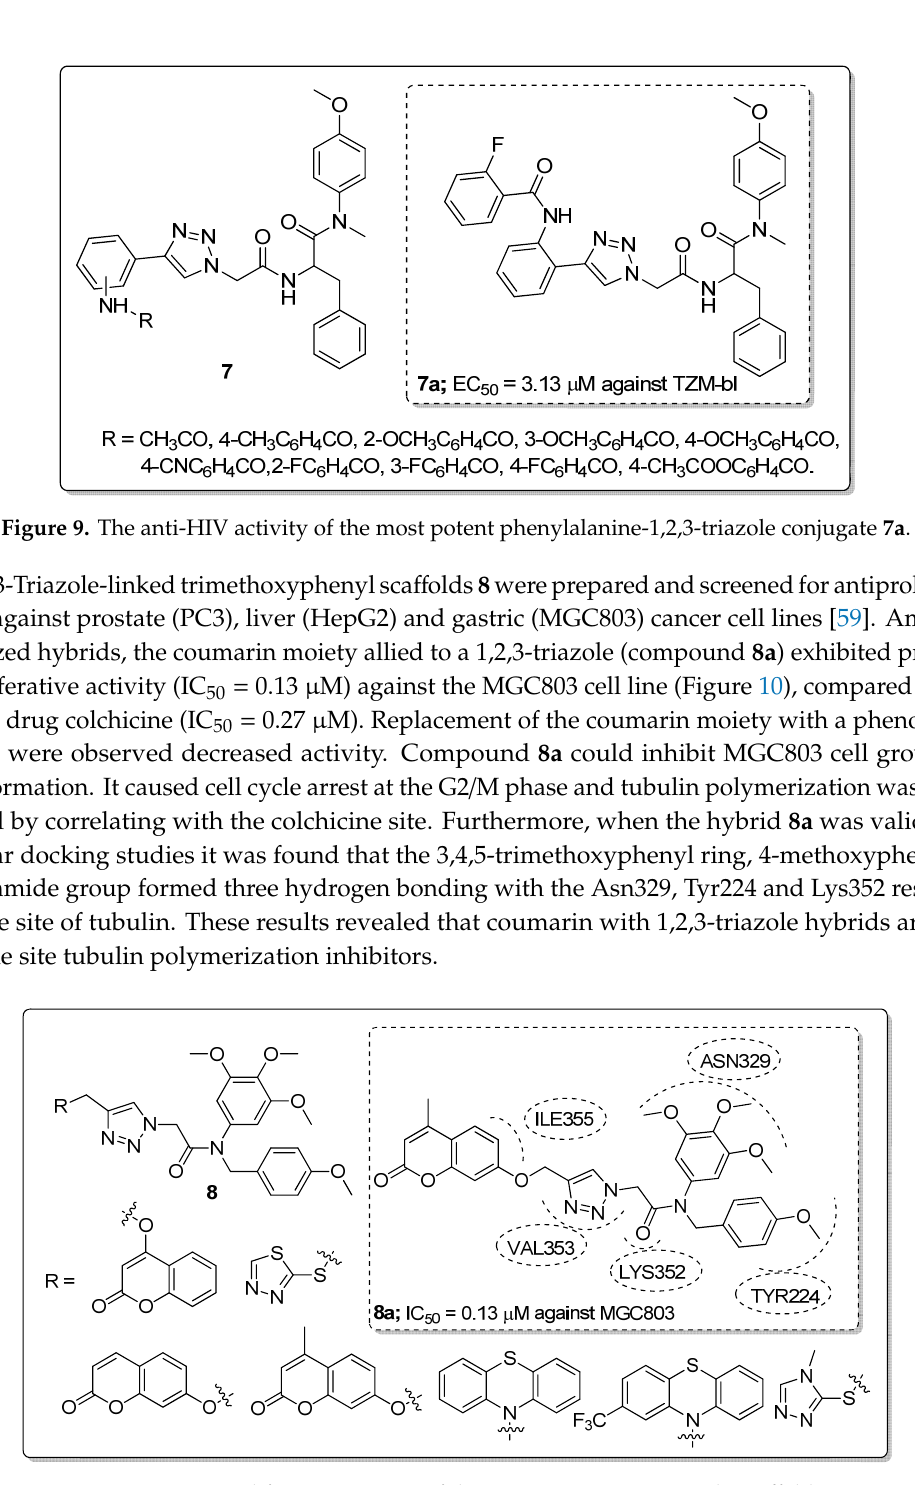
Figure 10. Antiproliferative activity of the most active 1,2,3-triazole scaffold 8a .